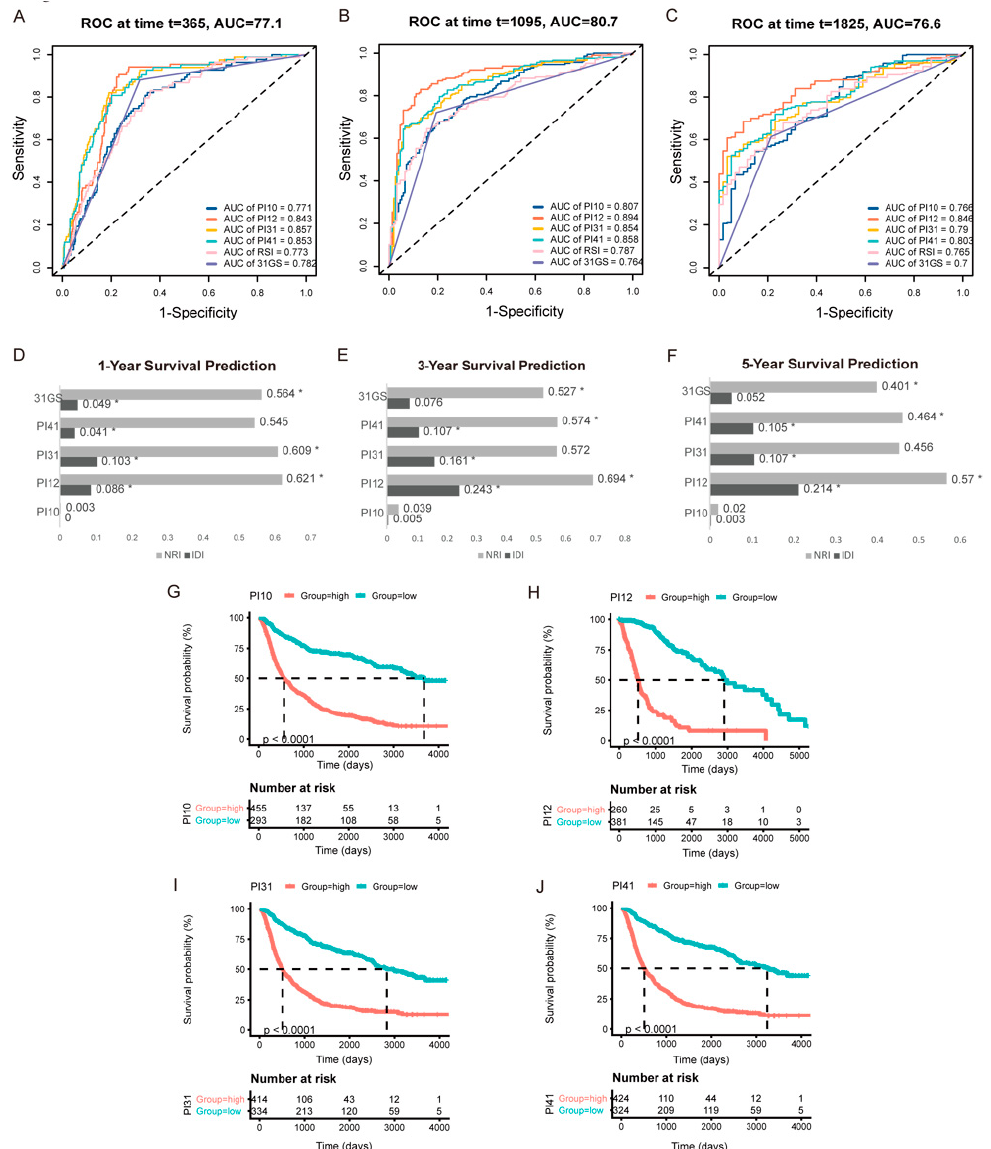
Figure 5. External validation of the selected markers in predicting glioma outcome in TCGA cohort. One − year ( A ), three − year ( B ), and five − year ( C ) time-dependent ROC of the selected markers. AUC areas were calculated and exhibited below the figures. IDI and NRI were calculated to compare the predictive accuracy of the 6 selected markers for 1 − year ( D ), 3 − year ( E ), 5 − year ( F ) ROC. RSI was applied as the referent marker. * p < 0.05. ( G – J ) Prognostic significance of PI10, PI12, PI31, and